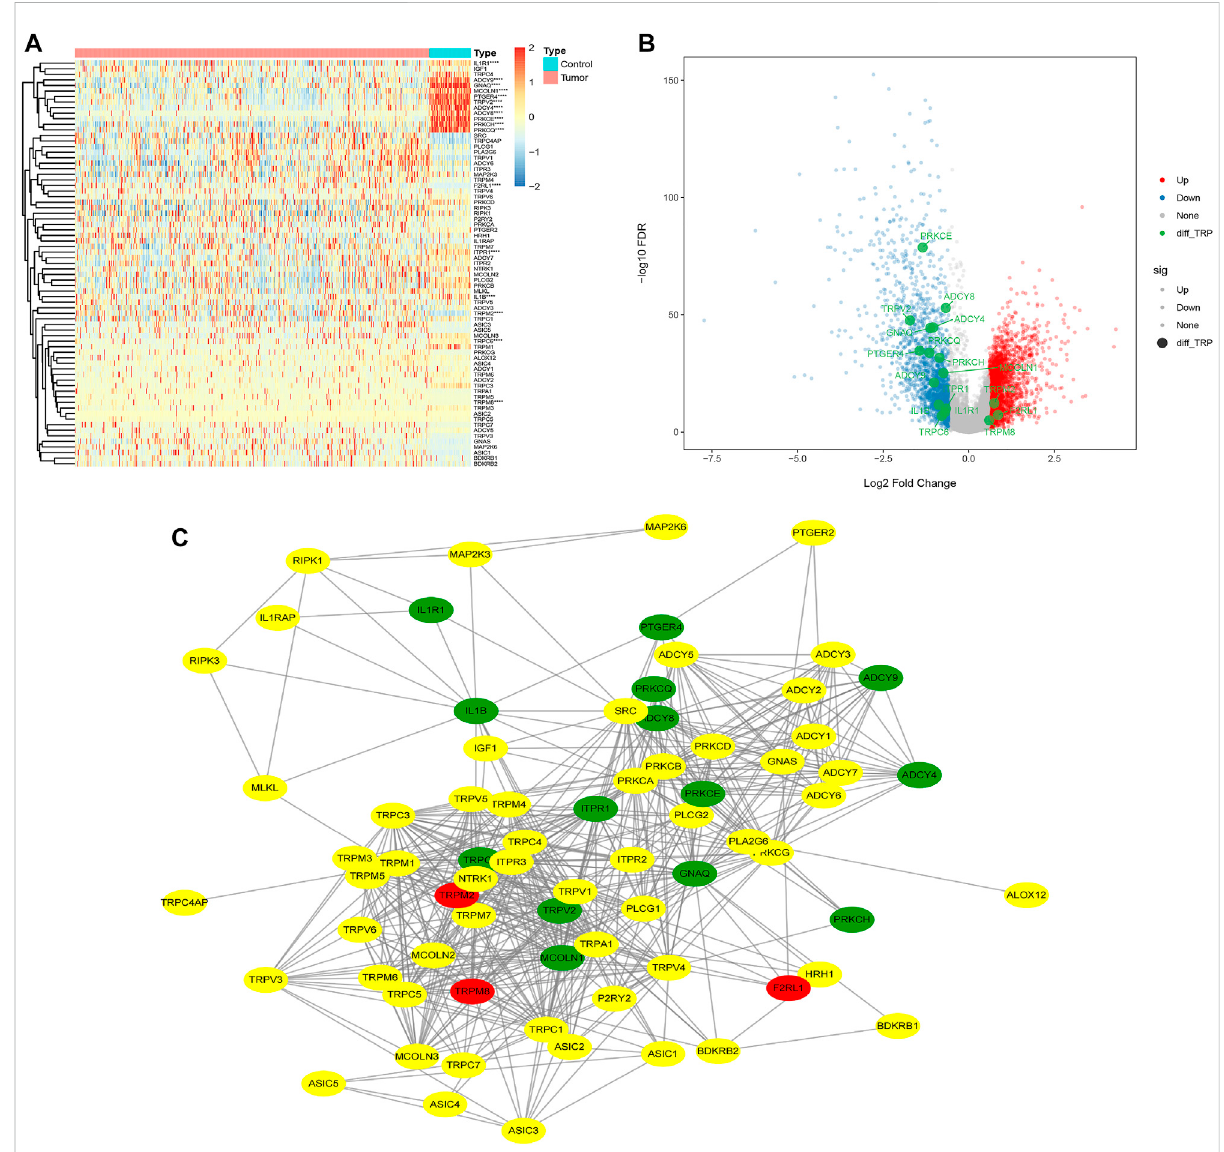
FIGURE 1 Differentialheatmapof73TRP-relatedgenes (A) ;volcanomapshowsthe17ofthemostsigni fi cantlyDEGs (B) ;Protein-proteinInteraction(PPI) of TRP-related Genes (C)